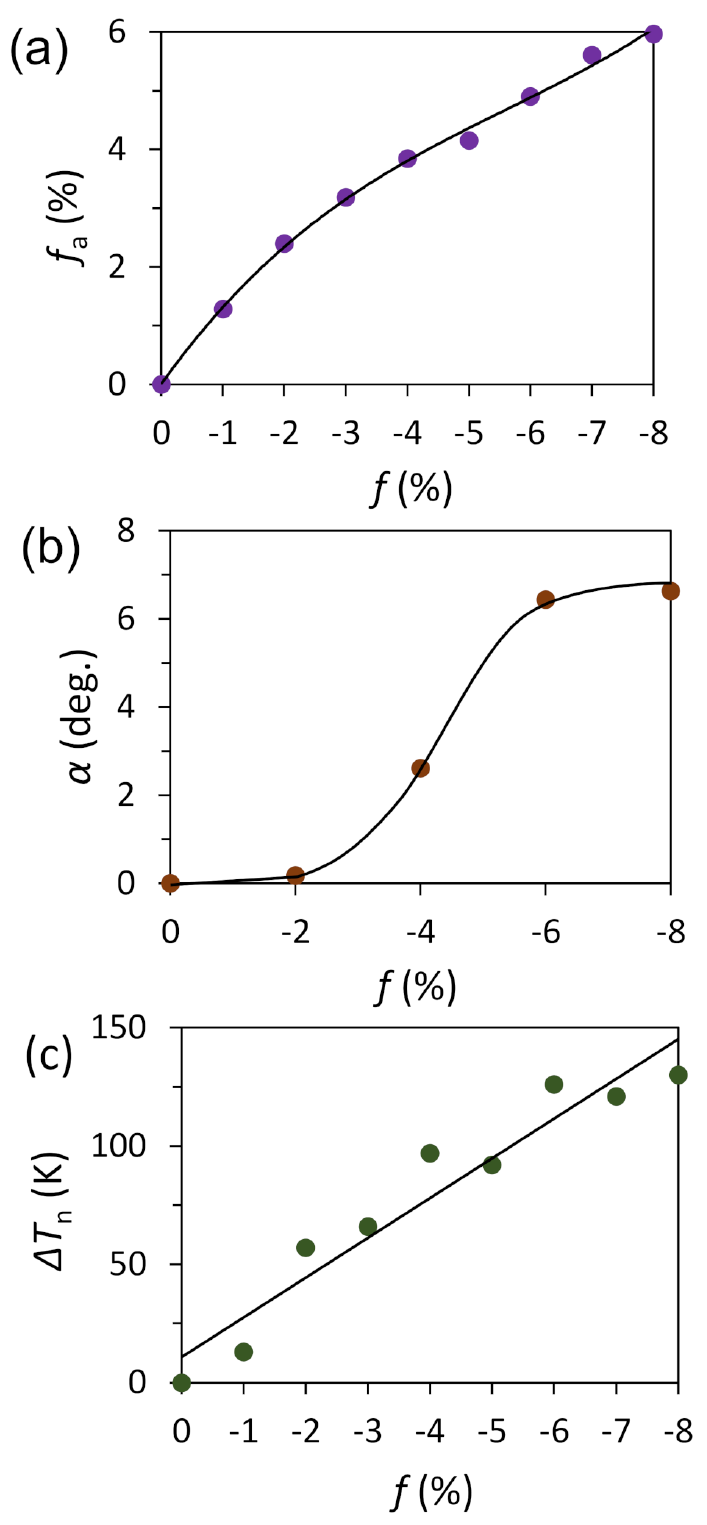
Figure 9. Effect of lattice misfit [11]. ( a ) lattice misfit accommodated by L1 ( f a ), ( b ) the total twist angle ( α ) of the solid relative the substrate; and ( c ) the nucleation undercooling ( ∆ T n ) as a function of the initial lattice misfit ( f